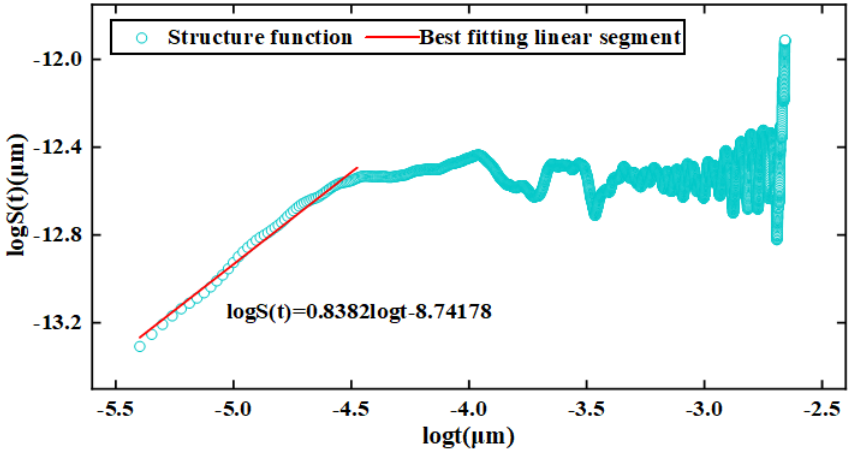
Figure 11. Structure function of the raceway surface profile in Ox direction.